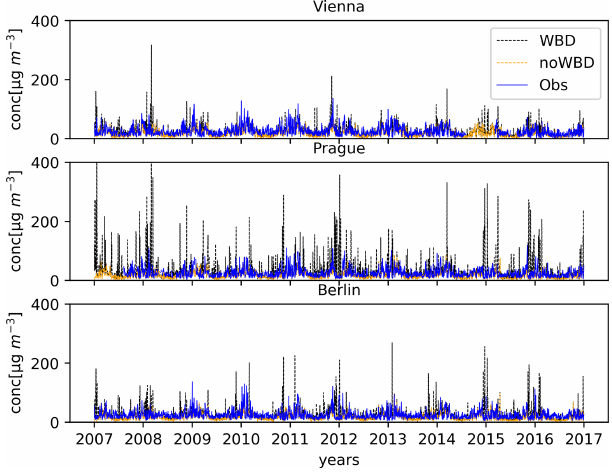
Figure 12. Averaged daily PM 10 concentrations of WBD (dashed black lines), noWBD (dashed orange lines) and the AirBase dataset (solid blue lines) for 2007–2016 (Vienna, Prague, Berlin). Units are micrograms per cubic metre.